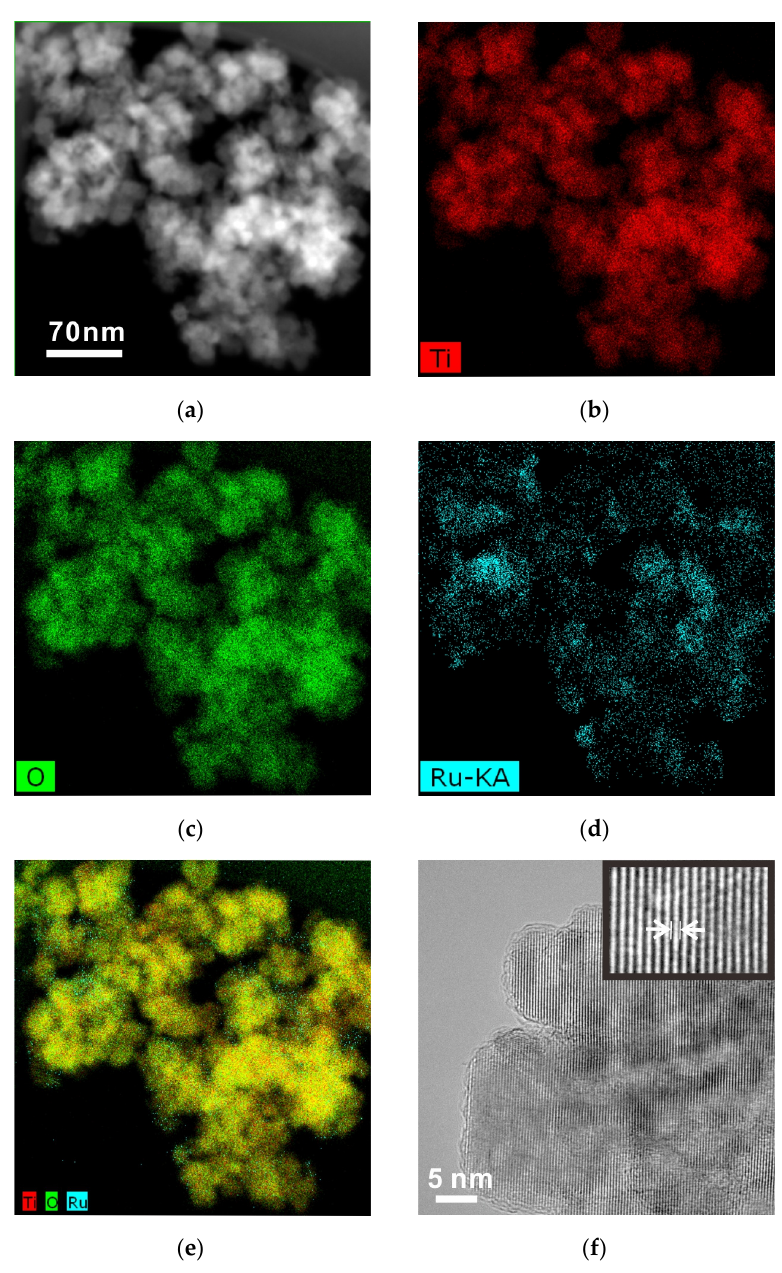
Figure 4. TEM image and Energy-dispersive X-ray spectroscopy (EDS) element mapping of Ru 0.07 TiO 2 . ( a ) TEM image of Ru 0.07 TiO 2 ; ( b ) Ti mapping; ( c ) O mapping; ( d ) Ru mapping; ( e ) overlapping of Ti, O, and Ru; ( f ) high resolution TEM image of Ru 0.07 TiO 2 (insert: interlayer spacing of d(101) = 0.35 nm).